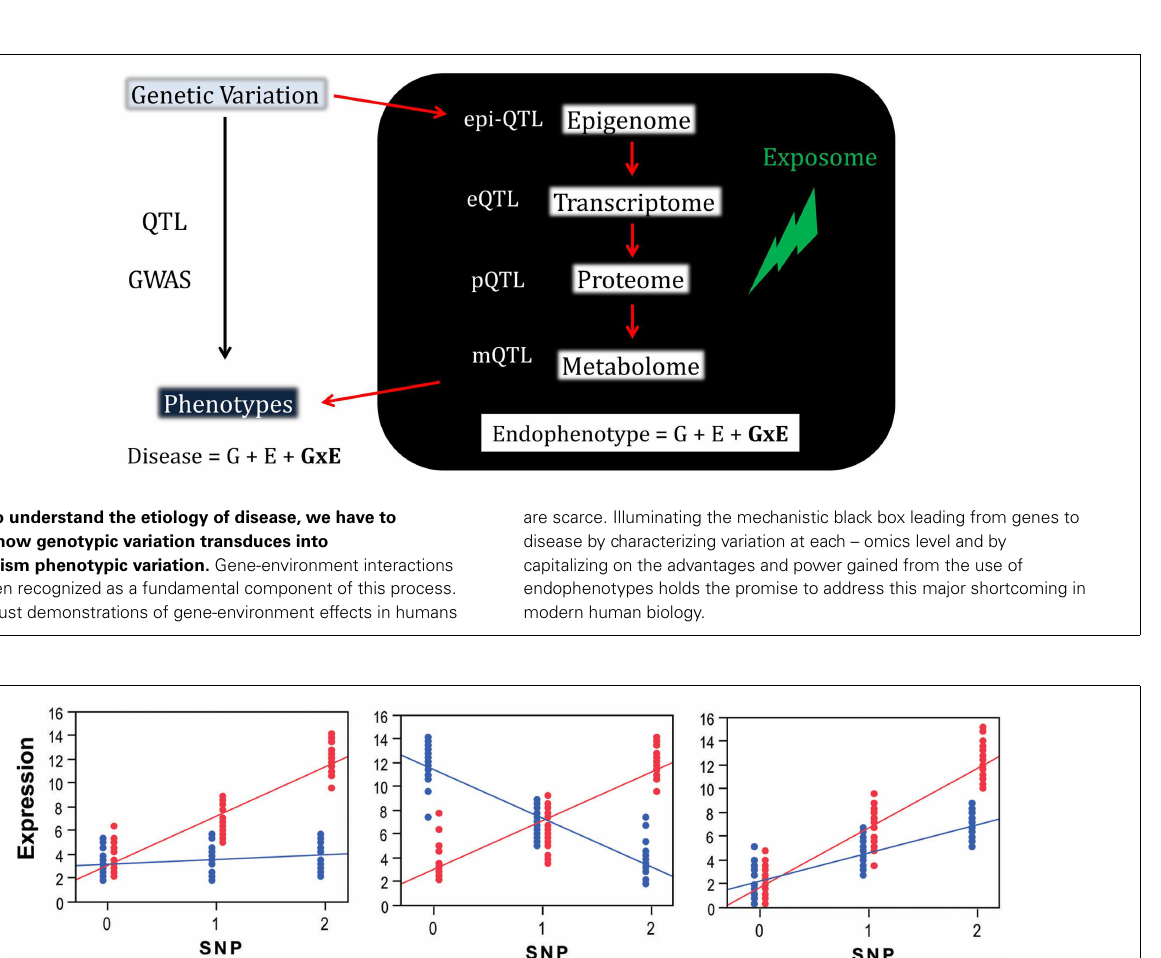
scenario where the eSNP effect is present in both conditions but is in the opposite direction giving rise to significant differential expression in both homozygote classes.The panel to the right shows the scenario of a quantitative statistical interaction where the eSNP effect is observed in both conditions in the same direction but at different magnitudes. Genotypes on the x -axis are labeled to indicate the number of minor alleles and individuals are labeled to indicate their exposure status (exposed, red; unexposed, blue). On the y -axis are relative expression